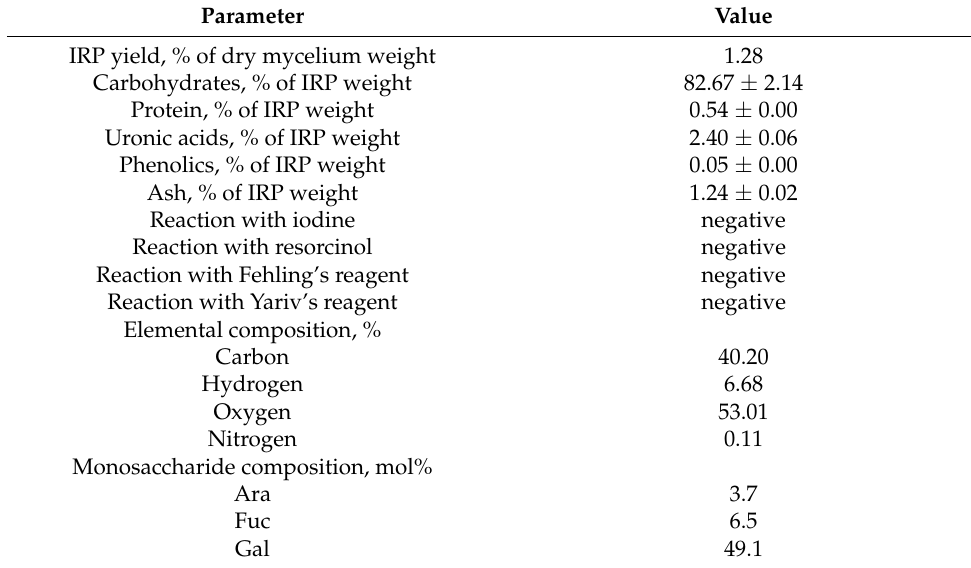
Table 1. Yield and chemical composition of total polysaccharide fraction of I. rheades mycelium